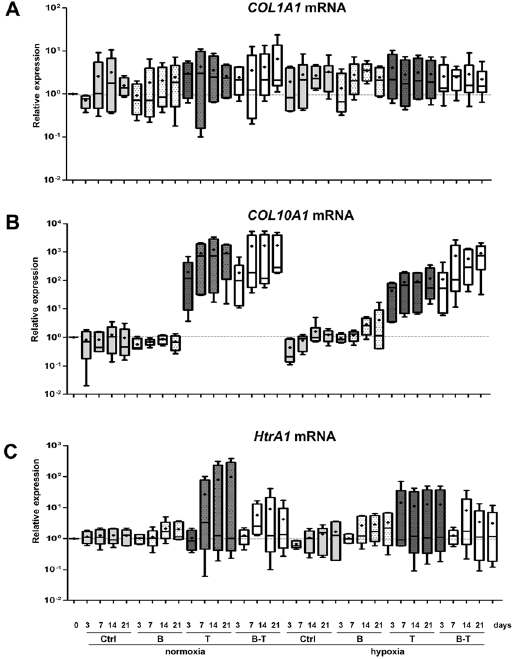
Figure 4. Effects of oxygen tension, BMP-2 and/or TGF- β 1 on the mRNA levels of nonspecific cartilage markers and the protease HtrA1. hBM-MSCs were cultured in type I collagen sponges for 3, 7, 14, and 21 days as described in Fig. 3. The levels of mRNA encoding type I collagen ( COL1A1 mRNA) ( A ), type X collagen ( COL10A1 mRNA) ( B ) and HtrA1 ( HtrA1 mRNA) ( C ) were measured using real time RT-PCR with specific primers. All the results were normalized to RPL13a mRNA and are presented as the expression of each gene relative to that of undifferentiated hBM-MSCs at day 0. Box plots represent independent experiments performed in triplicate (n = 4). Statistically significant differences between the undifferentiated cells at day 0 and treated cells are presented and were determined using the Kruskall-Wallis test ( * P <